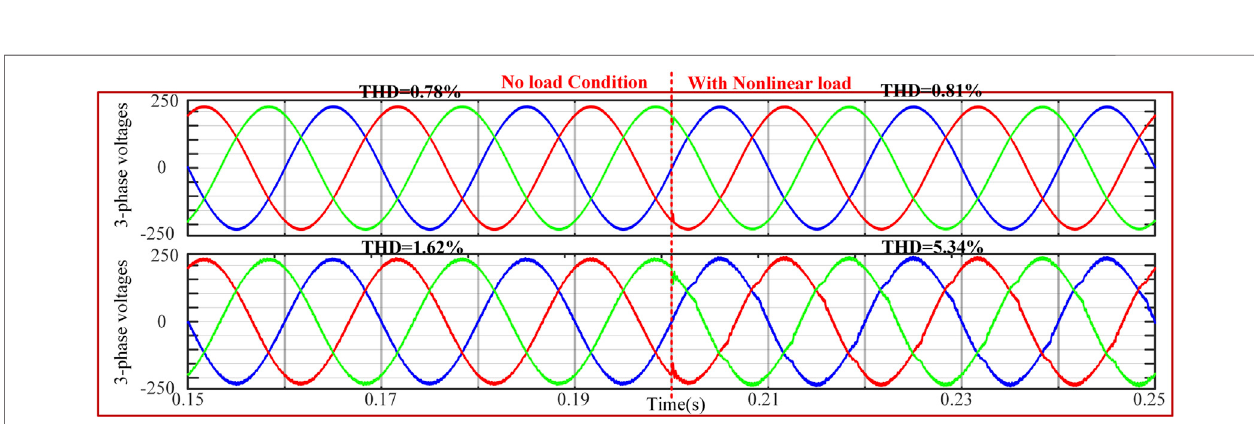
Frontiers in Energy Research |